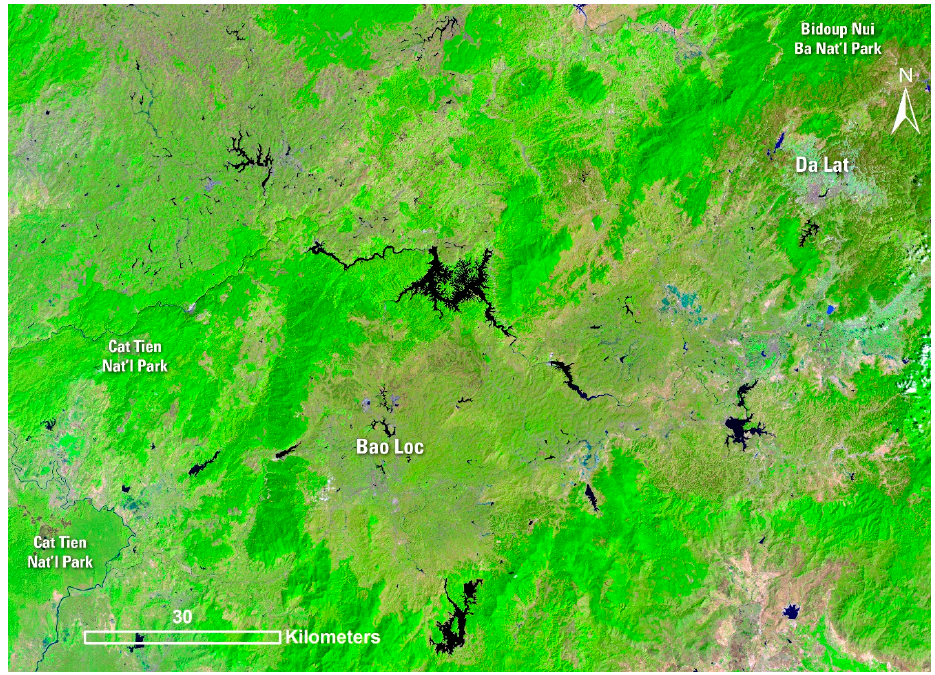
Figure 2. Location of a few key features of interest in the study region.